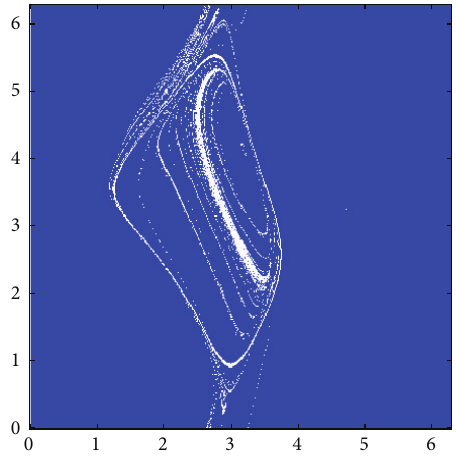
Figure 8: The convergence region of FDPF for IEEE 14-bus system on ( 𝜃 2 , 𝜃 3 )